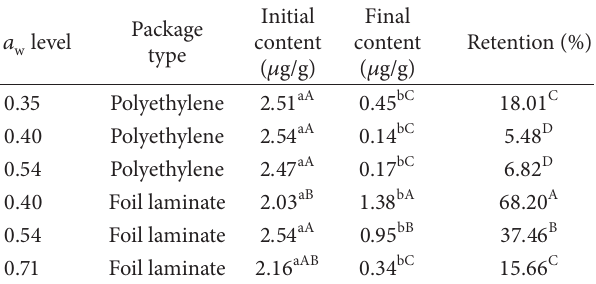
Table 5: Thiamin content of dehydrated taro slices stored for 34 levels and in different packaging materials 1 weeks at different 𝑎 w